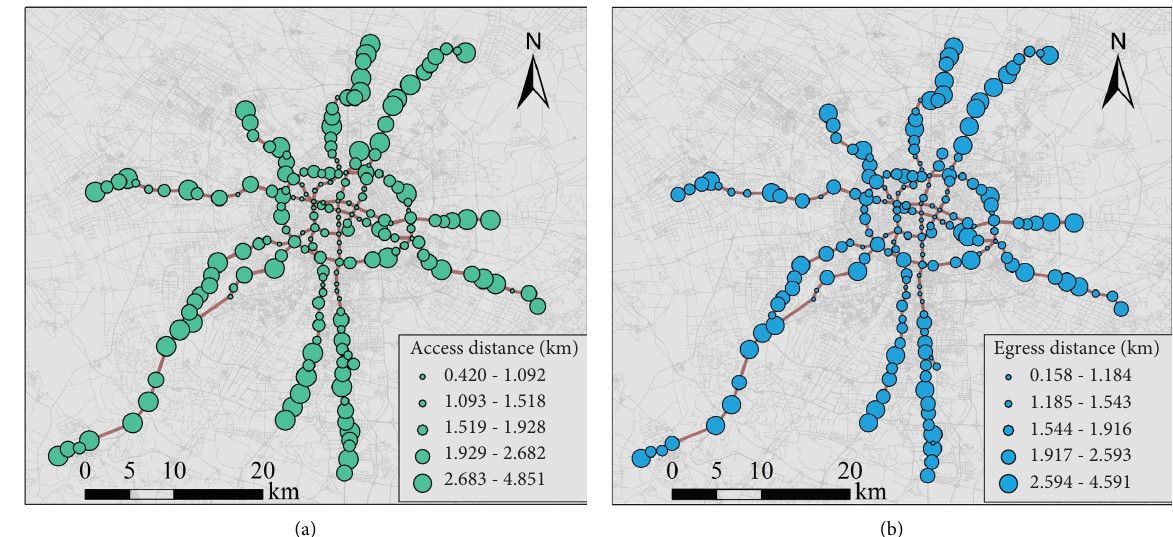
Figure 5: Spatial distribution of the 85th quantile distances. (a) Spatial distribution of access distance and (b) spatial distribution of egress distance.